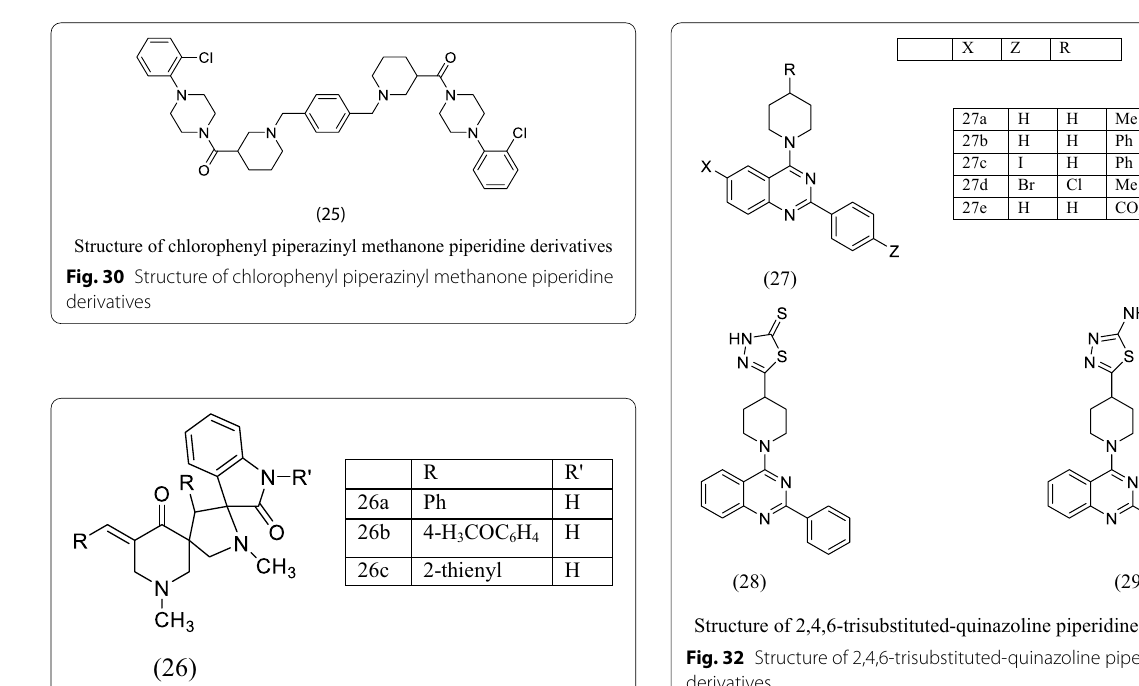
Fig. 32 Structure of 2,4,6‑trisubstituted‑quinazoline piperidine derivatives